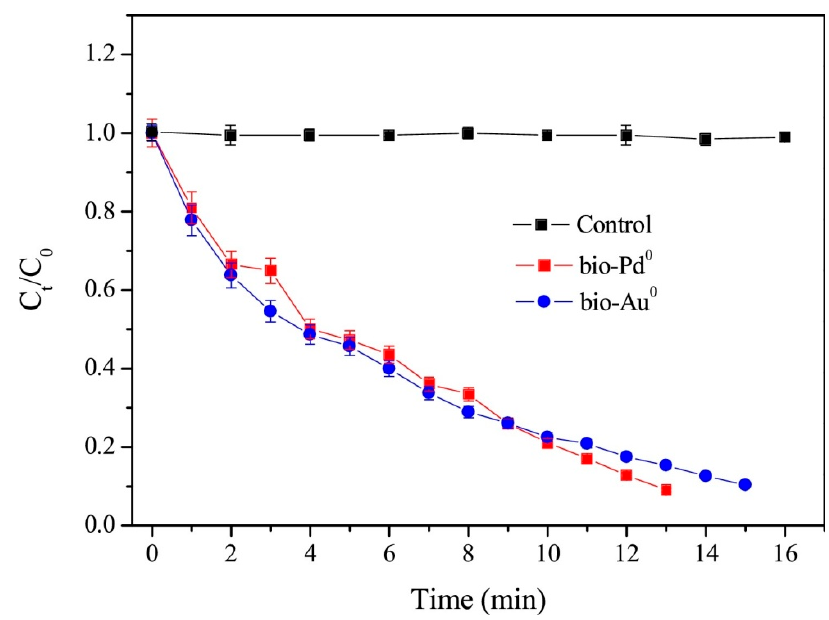
Figure 7. The catalytic performance of bio-Pd-NPs and bio-Au-NPs on 4-NP reduction. (reprint from [96] with permission from Elsevier. Copyright 2018).